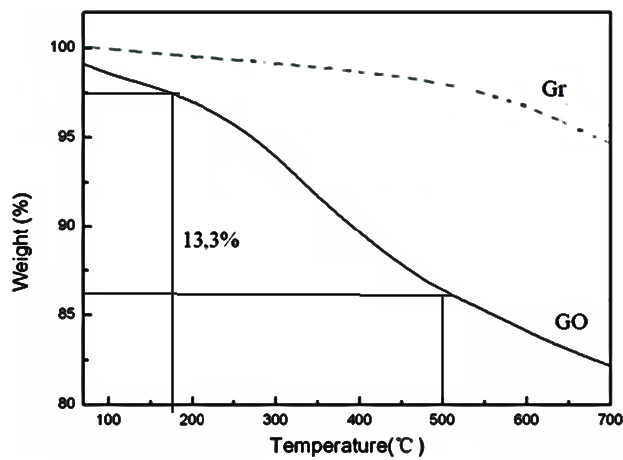
Figure 2. Thermogravimetric analysis (TGA) curves of graphite and graphene oxide.